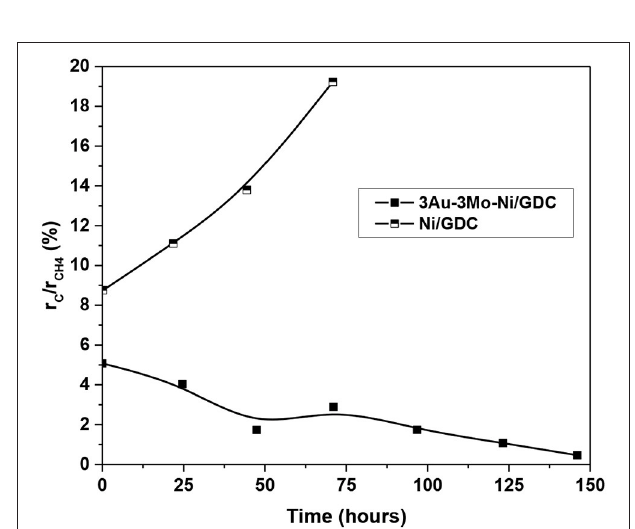
FIGURE 16 | Evolution of the % selectivity to carbon formation, for the examined cells with 3Au-3Mo-Ni/GDC ( (cid:4) ) and Ni/GDC ( • ) anodes. Selectivity is expressed as the % ratio of the carbon formation rate (r C ) to the consumption rate of methane (r CH Reprinted with permission from Neofytidis et al. (in